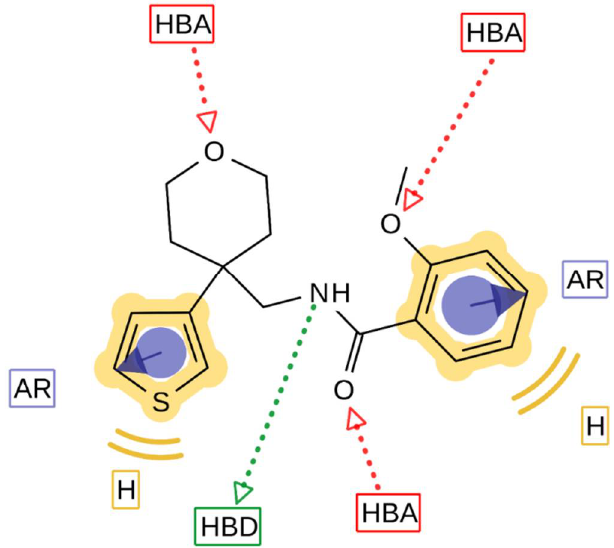
Figure 7. Pharmacophore model of new K V 1.3 inhibitors. The model was prepared in the Ligandscout 4.4 Expert (Inte:Ligand GmbH) [22,29] using molecules with inhibition of K V 1.3 higher than 75% at 10 µ M concentration. Pharmacophore features represent: hydrophobic interactions, yellow spheres; aromatic interactions, blue discs; hydrogen bond donor, green arrow; hydrogen bond acceptors, red arrows. The pharmacophore model shows the most important features of K V 1.3 inhibitors with the most potent compound 44 aligned to the pharmacophore